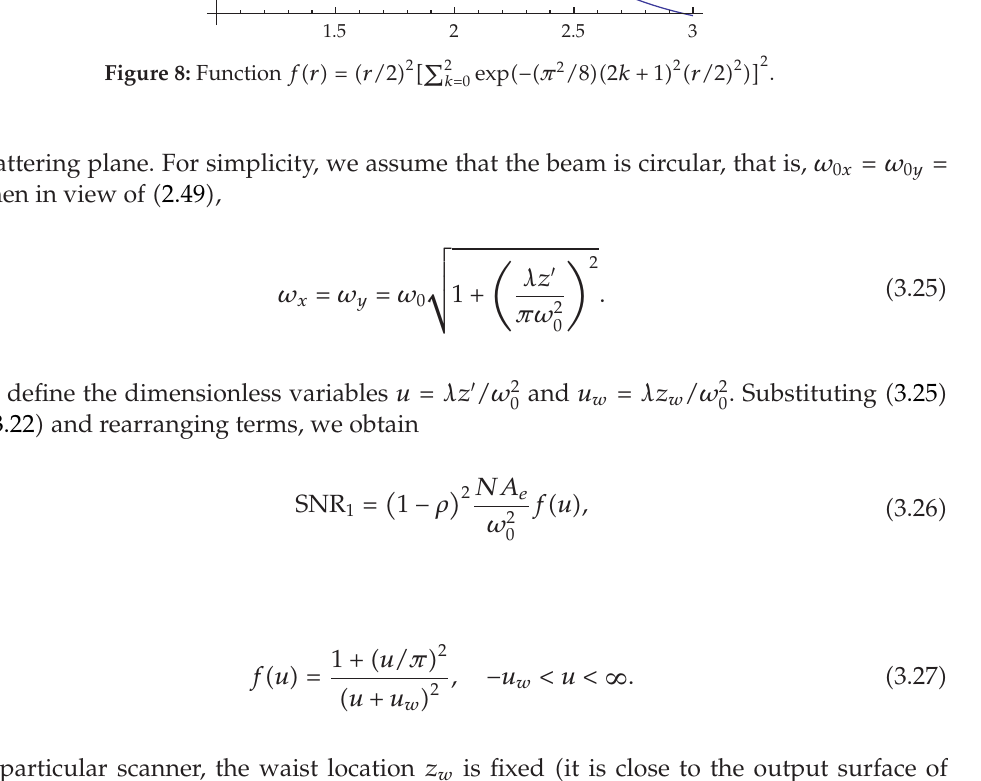
Figure 8: Function f (cid:3) r (cid:4) (cid:5) (cid:3) r/ 2 (cid:4) 2 (cid:6)